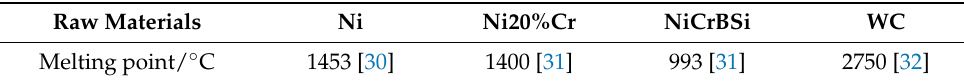
Figure 3. The coating porosity and surface roughness. Table 3. The melting point of raw